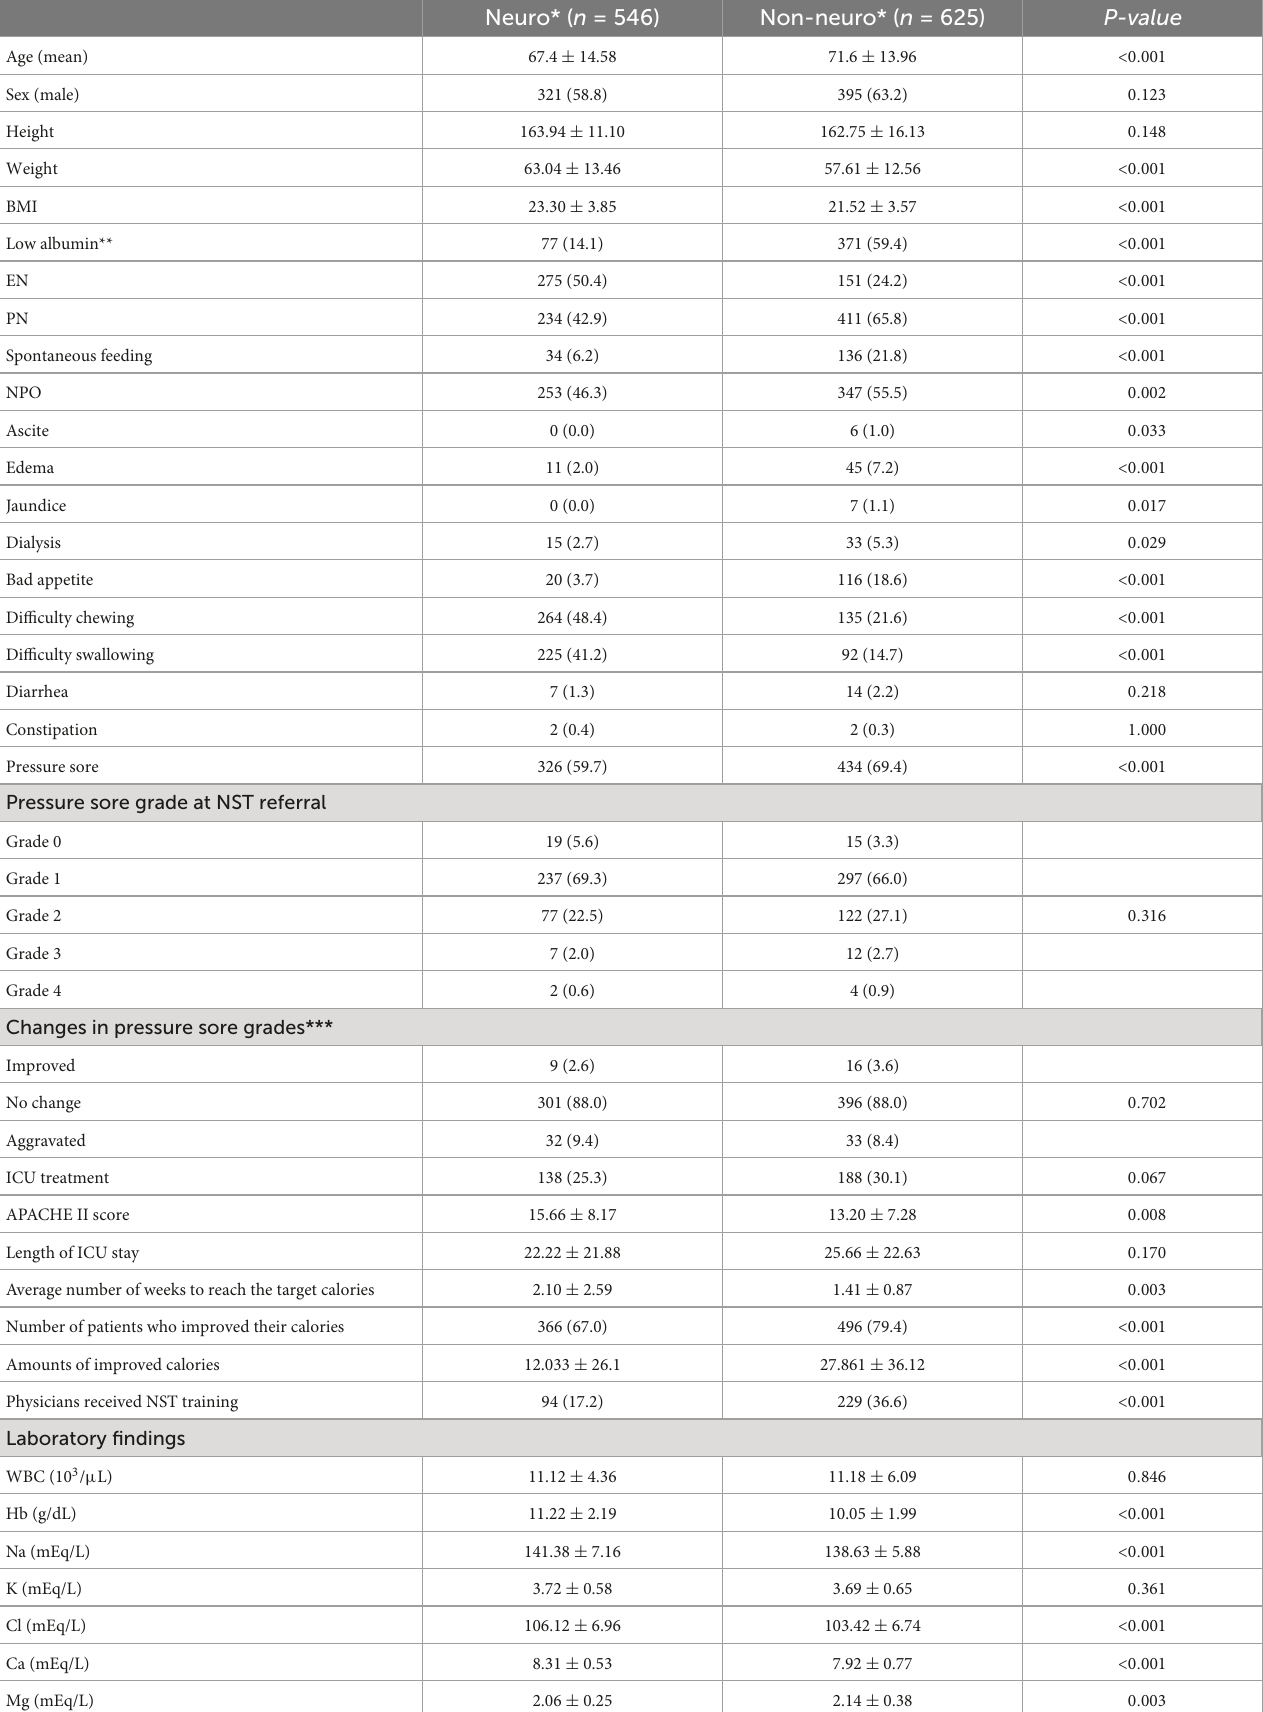
TABLE 2 Differences of patient characteristics according to